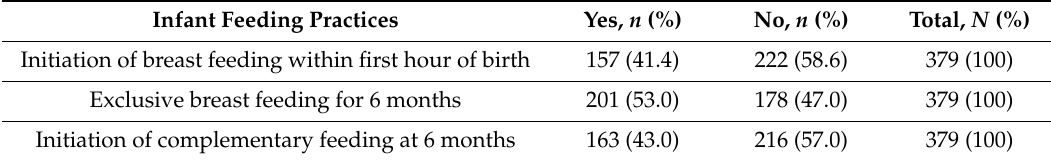
Table 1. Infant feeding practice among mothers in rural Southern Nepal, 2016. Infant Feeding